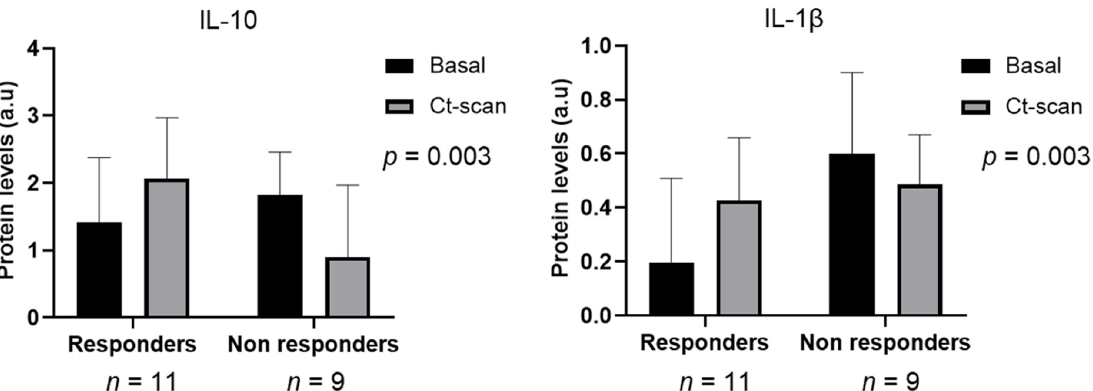
Figure 2. IL1-10 and IL-1 β dynamics in responders and non-responders. Cytokine levels are represented in 2 different time-points (basal: black; after CT assessment; grey). General lineal model was used to test for statistical significance and both demonstrated very significant ( p < 0.01) statistical differences.